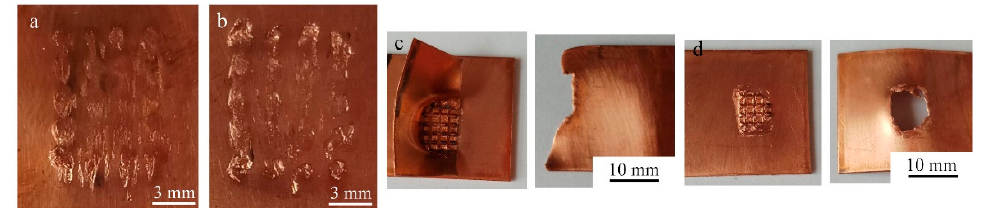
Figure 11 . Fracture morphology of the joints fabricated at the pressures of 0.45 MPa (without ( a ) and with ( b ) alcohol) and 0.55 MPa (with ( c , d ) without alcohol)